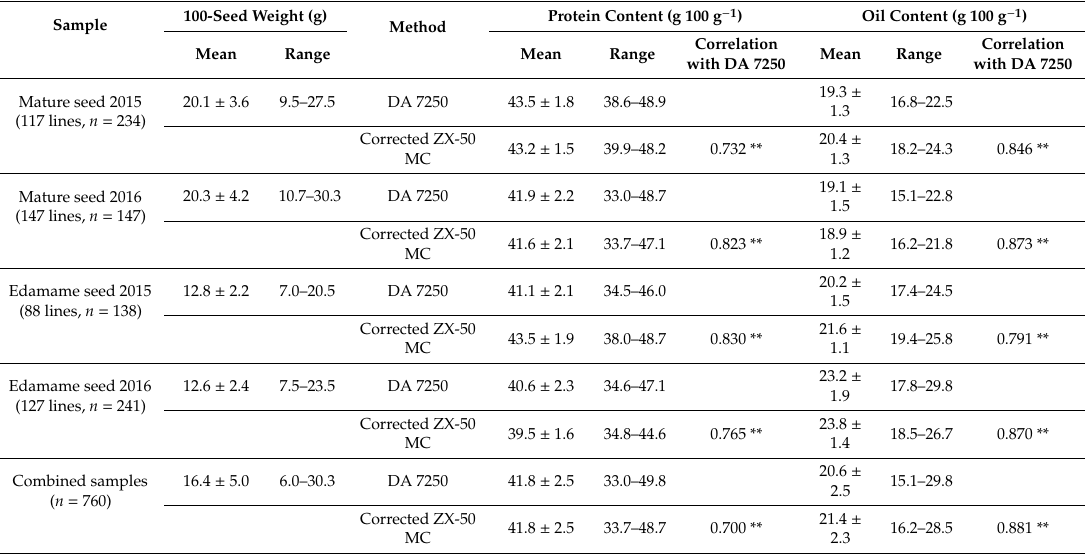
Table 6. Application of the ZX-50 MC method to evaluate soybean seed protein and oil content in di ff erent soybean seed samples and comparison with DA 7250.